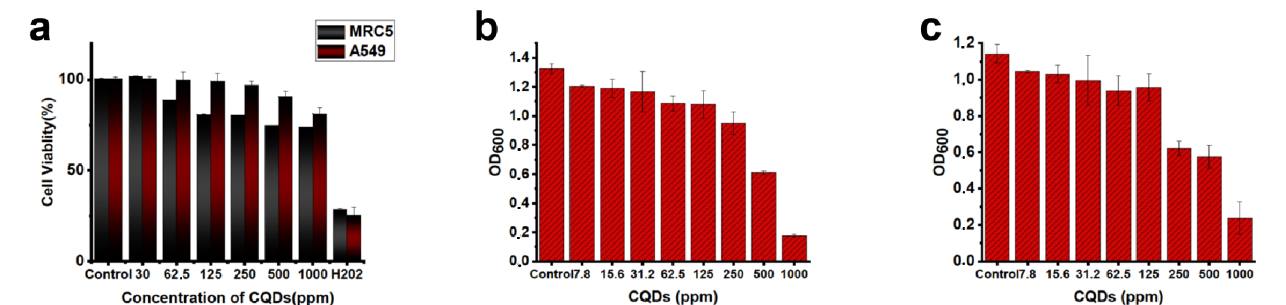
Figure 7. Cell viability of the A549 and MRC5 cells ( a ), and antimicrobial activity of CQDs against Escherichia coli strains at different concentrations in daylight ( b ), and dark ( c ).